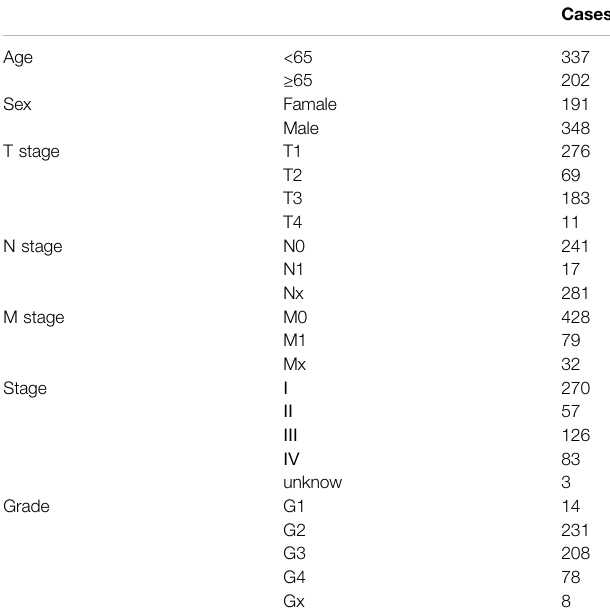
TABLE 1 | Clinicopathological details of 539 KIRC